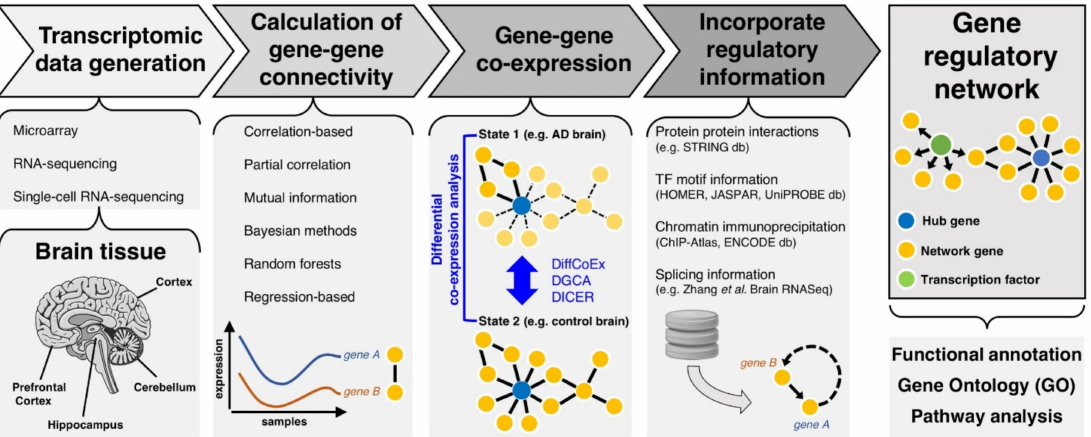
Figure 1. Schematic overview showing the workflow for gene network inference, from transcriptomic data generation to integration of regulatory information to assess gene regulatory